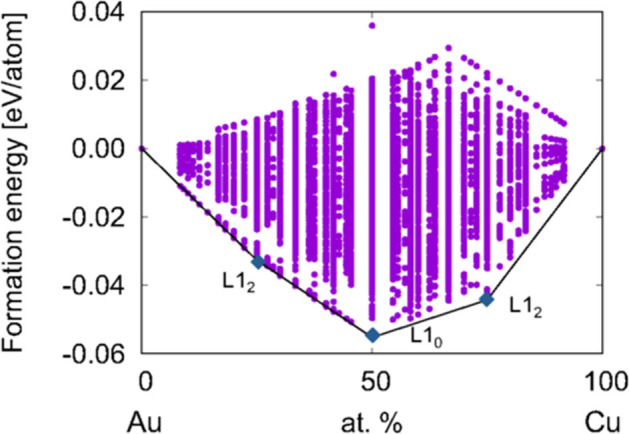
Convex hull of CuxAu1−x. Reproduced from Takeuchi et al. (2017) with permission from APS.